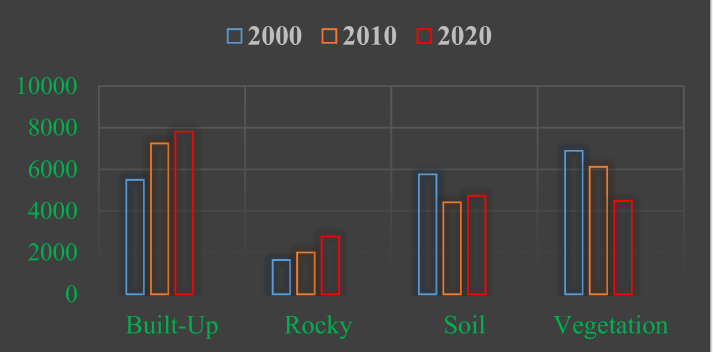
Figure 6. Land cover area (ha) of four classes at three dates provided by SAM classifier. Figure 6 is the diagram of land cover classes resulted from the SAM classification.